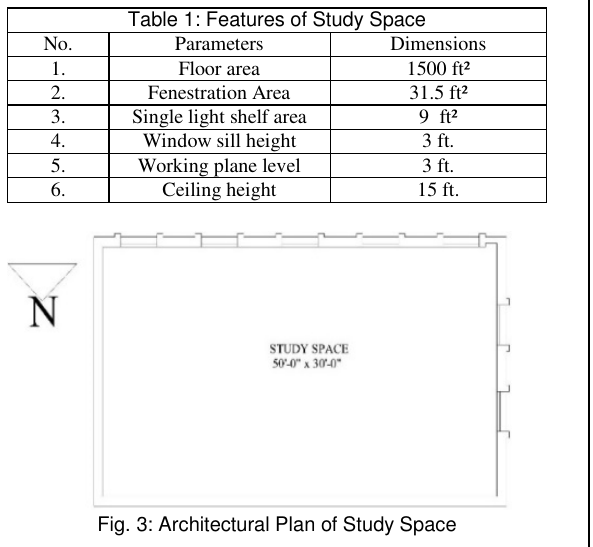
Table 1: Features of Study Space No.